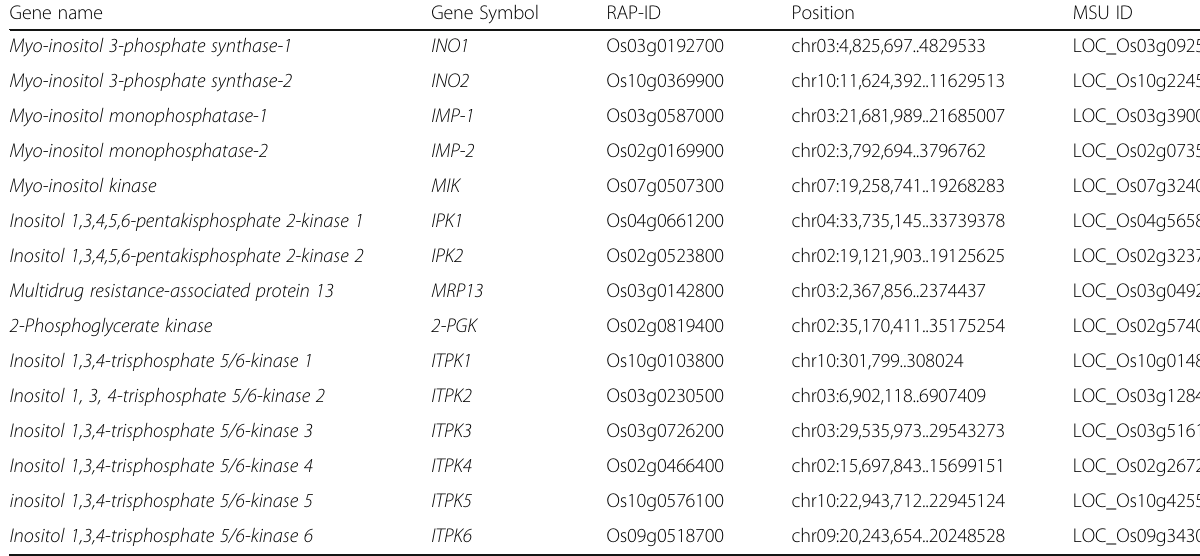
Table 1 List of the Genes Responsible for PA Biosynthesis and Transport in